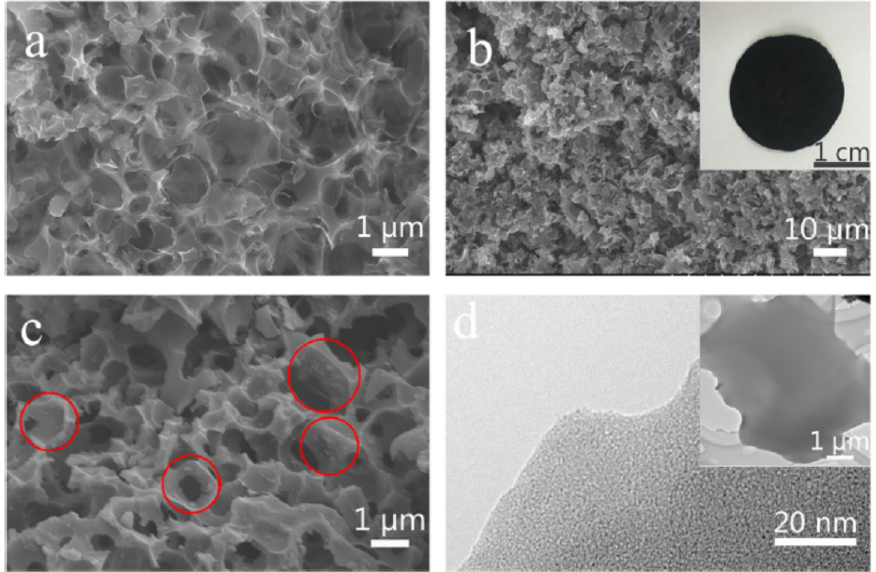
Figure 12. Microstructure of the porous carbon polyhedrals (PCPs): ( a ) SEM image of the porous carbon polyhedrals (PCPs), ( b , c ) SEM images of the modified PCPs, and ( d ) TEM image of the modified PCPs. The inset in ( b ) is the photo of the composite membrane with a diameter of 2 cm. Reprinted from [20], ©2020 The